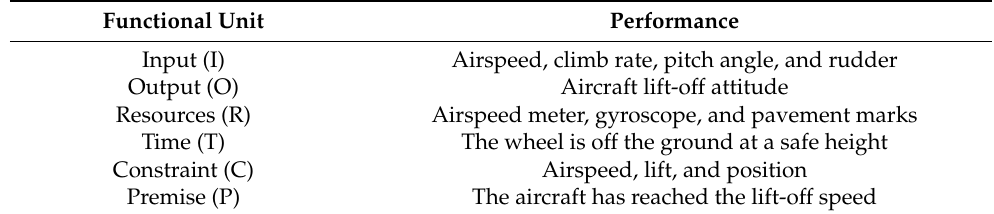
Table 5. “F8: Off-Ground” functional